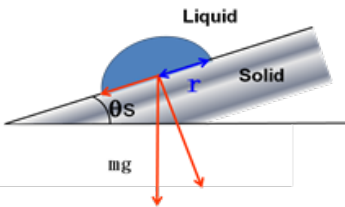
Figure 4. Schematic description of a water drop on a tilted solid